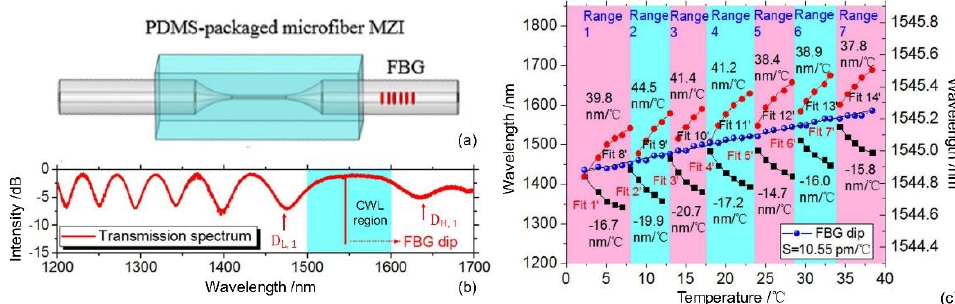
Figure 8. ( a ) Schematic diagram of the taper-based in-line MZI; the inset presents calculated inten- sity profiles of the interference two modes, HE 11 and HE 12 , respectively; ( b ) simulated dispersion factor Γ and ( c ) RI sensitivity as functions of the fiber diameter. Adapted with permission from Ref. [29].